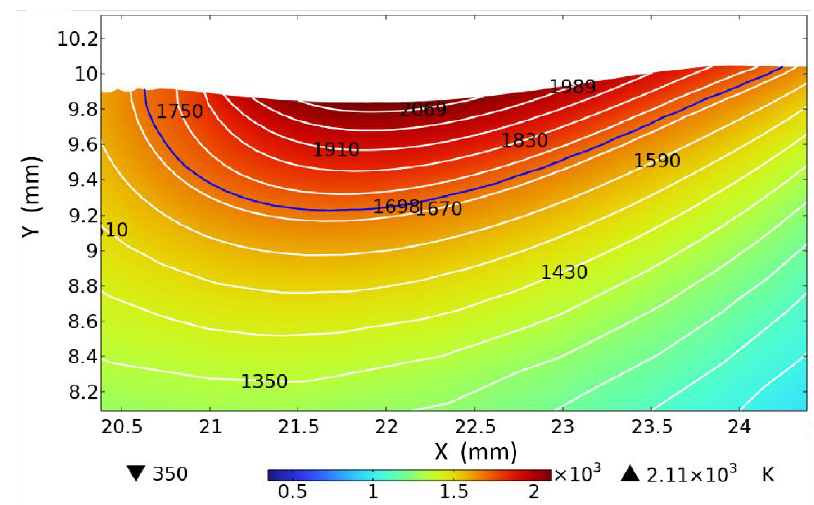
Figure 3. Temperature field distribution in the molten layer (B = 0 T, t = 4.5 s).